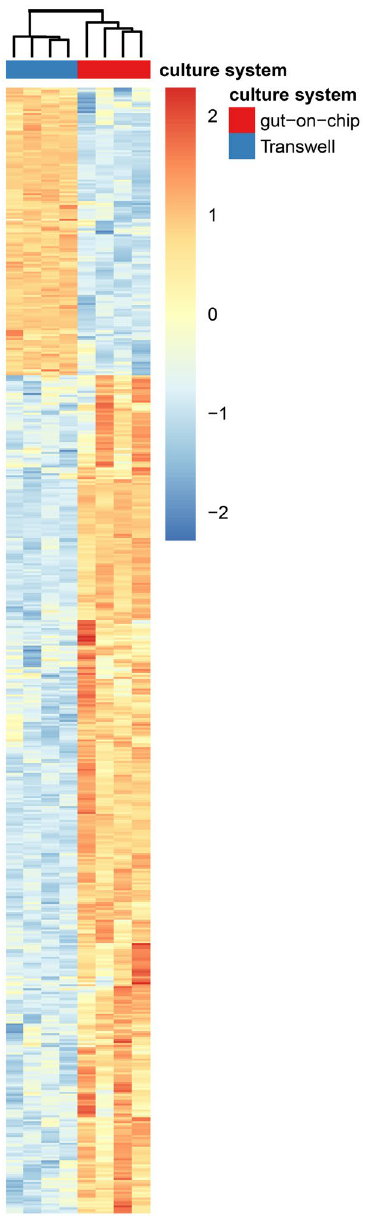
Figure 4. Heatmap showing the leading edge genes (575 genes in total) of 24 enriched gene sets. In the GSEA, gene expression patterns of Caco-2 cells cultured in a gut-on-chip were compared with those of Caco-2 cells cultured in Transwells. Heatmaps of selected genes were made using the R library pheatmap (version 3.6.3, https ://cran.r-proje ct.org/web/packa ges/Pheat map/index .html) 23